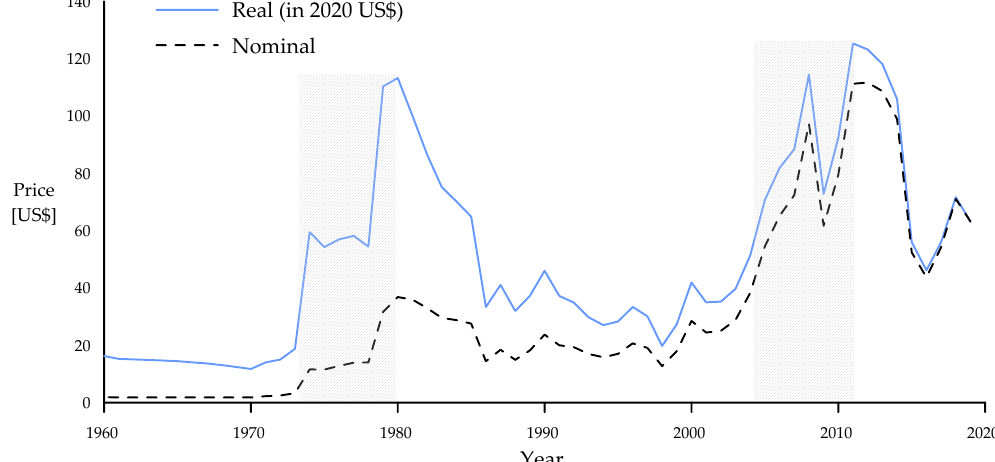
Figure 8. Crude Oil Prices from 1960 to 2020, nominal and real (corrected by the 2019 U.S. inflation). 1960–1985: Arabian Light posted at Ras Tanura; 1986–2020: Brent Spot. Price data source: U.S. Energy Information Administration [39]. U.S. Consumer Price Index (CPI) to correct the prices for the 2019 inflation sourced from the U.S. Bureau of Labor Statistics